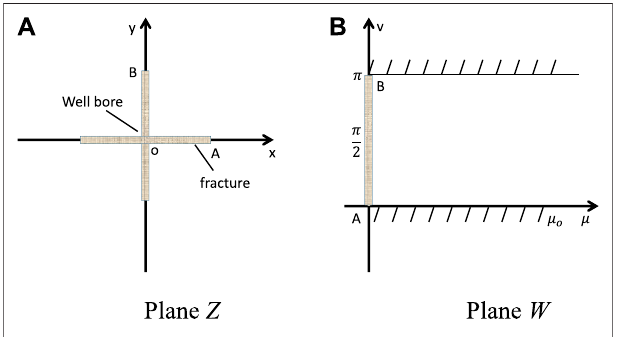
FIGURE 2 | Distribution map of 2 vertical fractures. (A) Plane Z. (B) Plane W.